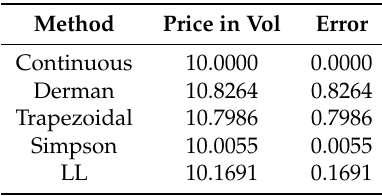
Table 2. Prices in volatility obtained by static replication of a variance swap under low volatility